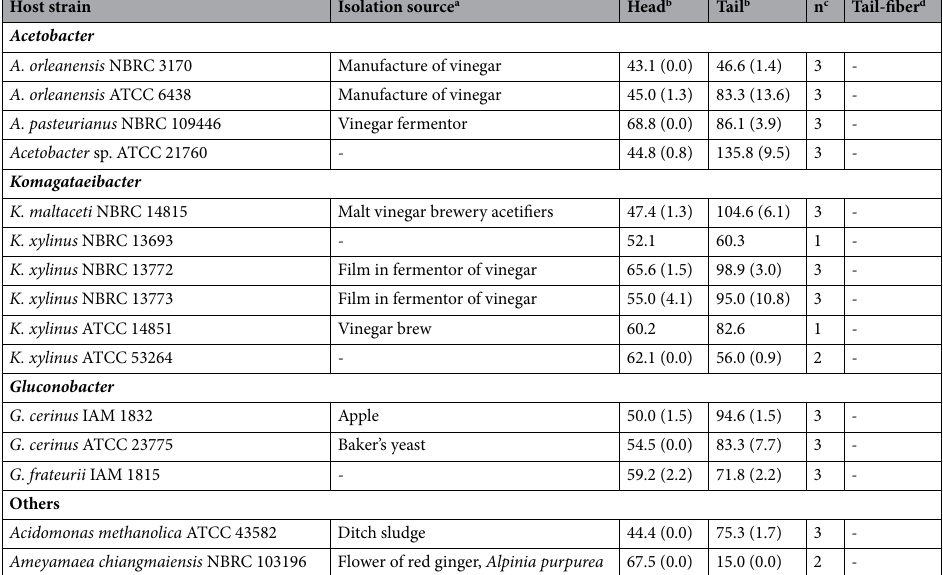
Table 1. Morphological characteristics of AAB temperate phages. a Dashes indicate unknown; b Values are Mean (SD) of phage size (nm); c n is measurement number of phage particle; d Dashes indicate not detected.